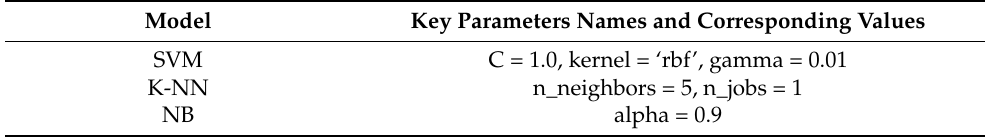
Table 3. The 5-fold cross-validation results are shown in Table 4, and the ROC curve of each model and the corresponding AUC value are shown in Figure 7. Table 3. The key parameters optimization results of the previous machine learning models.